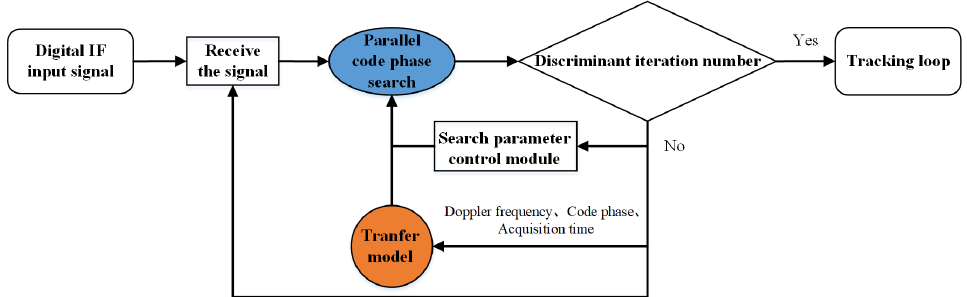
Figure 6. The process of parallel code phase search after ILS improved acquisition